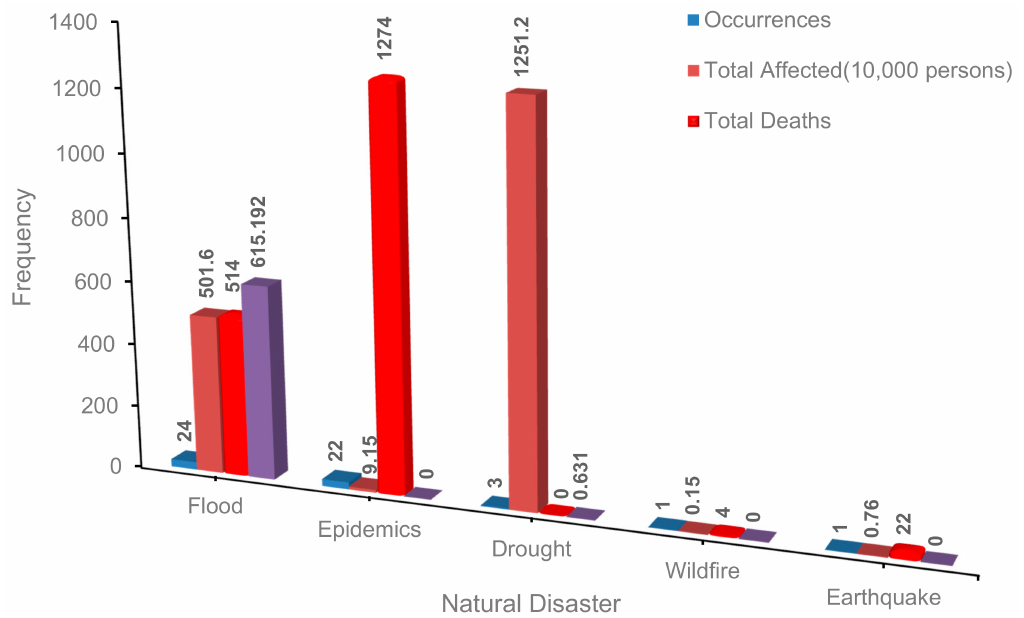
Figure 1. Natural disasters in Ghana by frequency and impacts